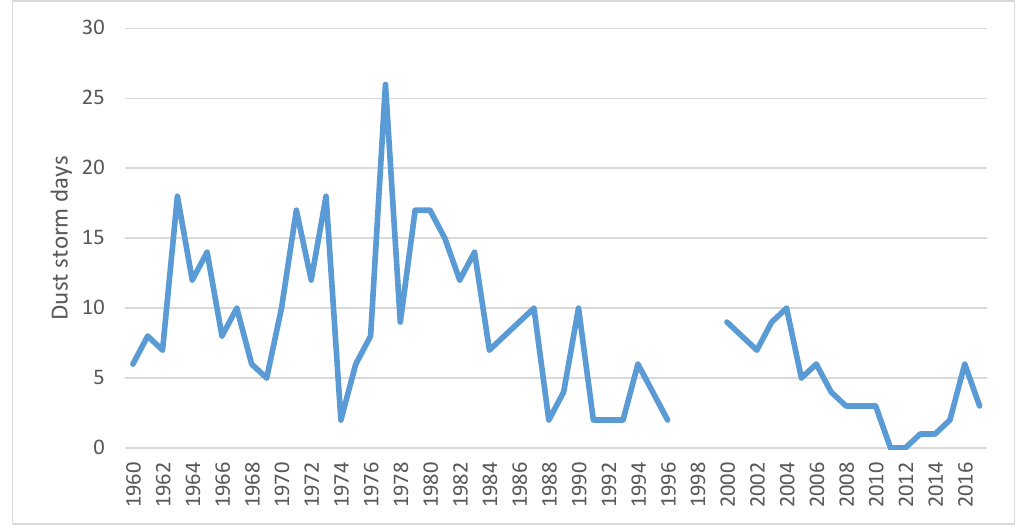
Figure 3. Annual frequency of dust storm days 1960 – 2017 at Minqin (38.63° N, 103.08° E). (Data source: Chinese Meteorological Administration, with data for years 1997 – 1999 unavailable).